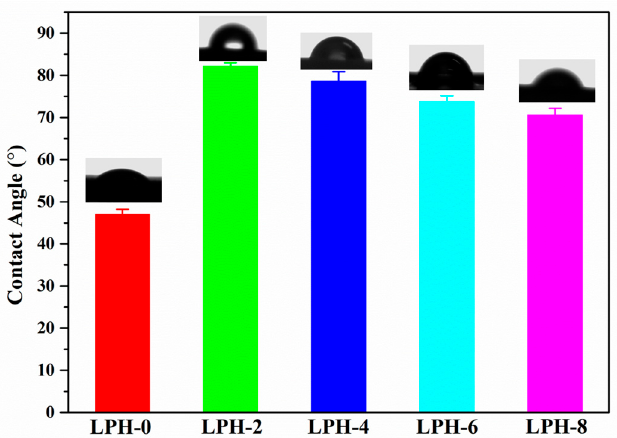
Figure 7. Representative images of water contact angle of LPH-0, LPH-2, LPH-4, LPH-6, and LPH-8 films.